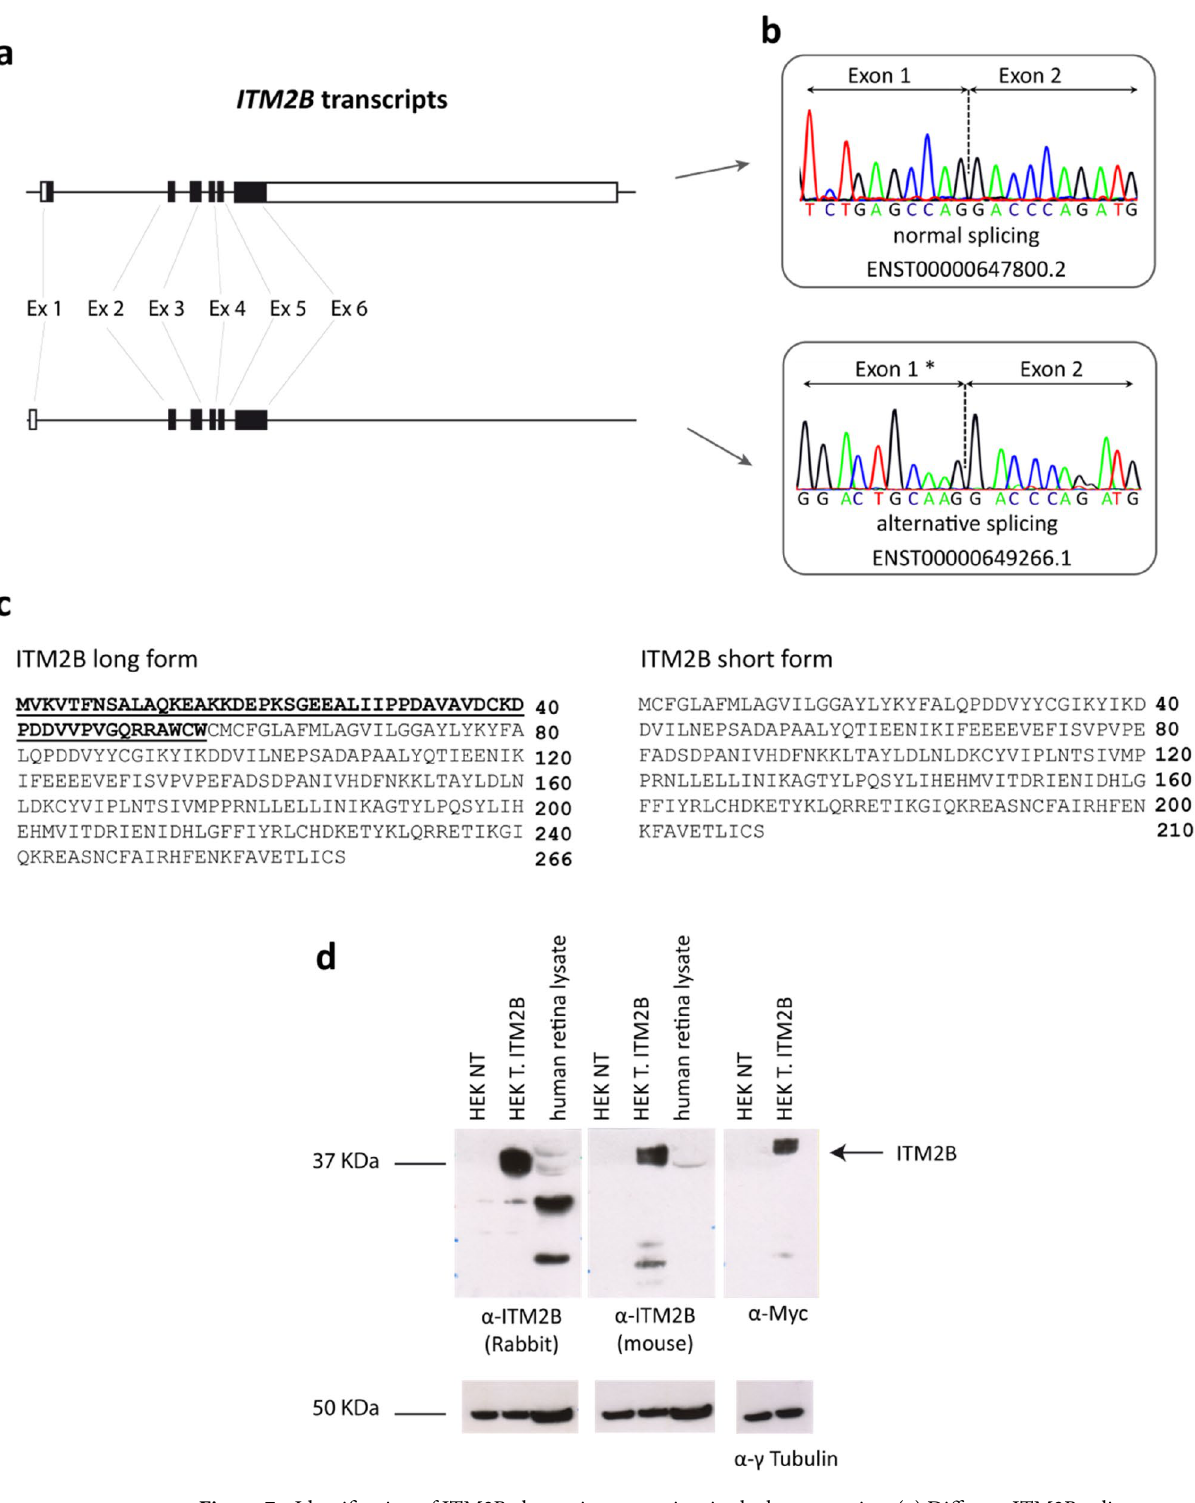
Figure 7. Identification of ITM2B alternative transcripts in the human retina. ( a ) Different ITM2B splice variants. ( b ) Identification of ITM2B alternative splicing in the human retina. ( c ) Amino acid sequence for ITM2B long isoform and predicted amino acid sequence for ITM2B short isoform. ( d ) Western blots on HEK 293 cells and retinal protein extract, NT non transfected, T transfected with ITM2B, anti-γ-tubulin is used as a loading control. Raw data of Western blots are presented in Supplementary Fig.